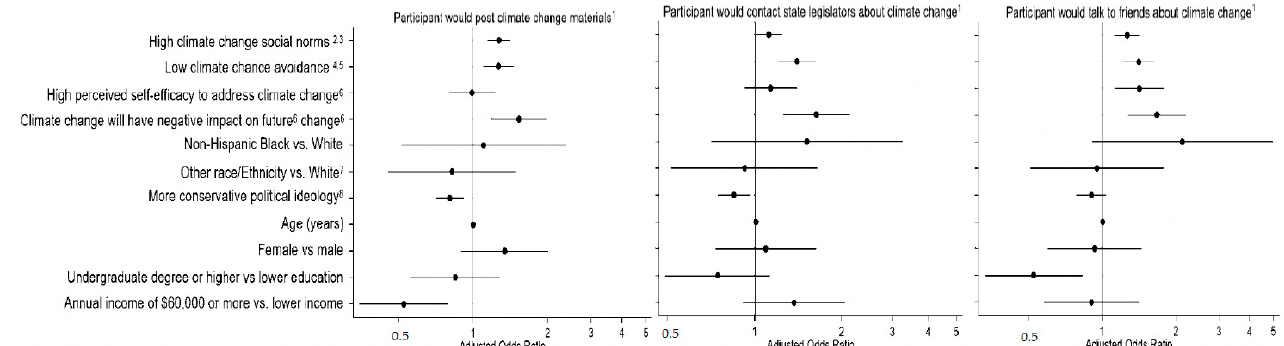
Figure 1. Visual Depiction of Adjusted Odds Ratios of Predictors of 3 Forms of Climate Change Communication Behaviors from 586 Participants who completed the MTurk Surveys at Waves 1, and 4. 1 Logistic regression with “no” as reference